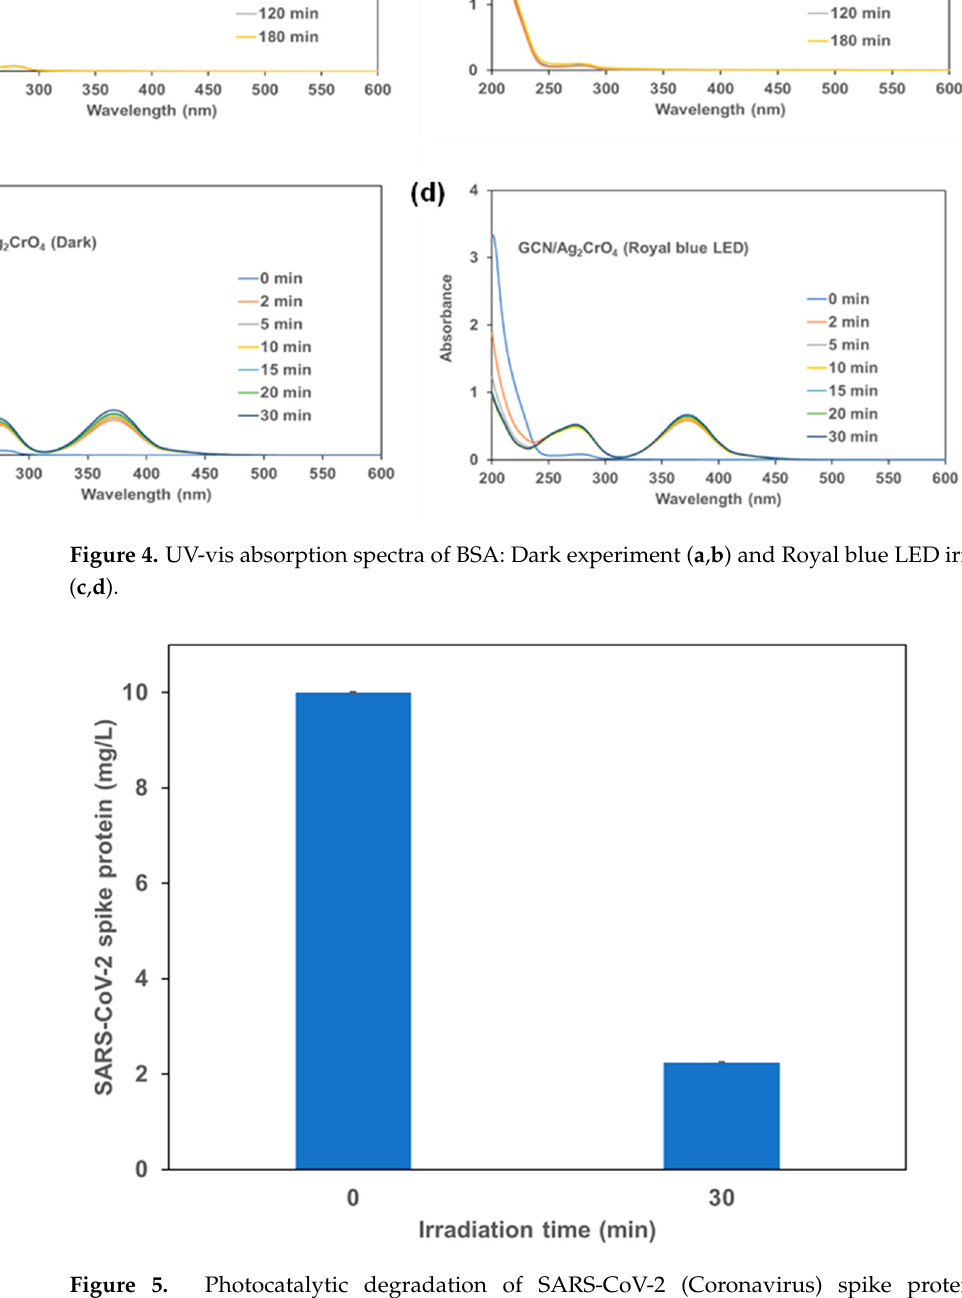
Figure 5. Photocatalytic degradation of SARS-CoV-2 (Coronavirus) spike protein using GCN/Ag 2 CrO 4 . Under royal blue LED irradiation.